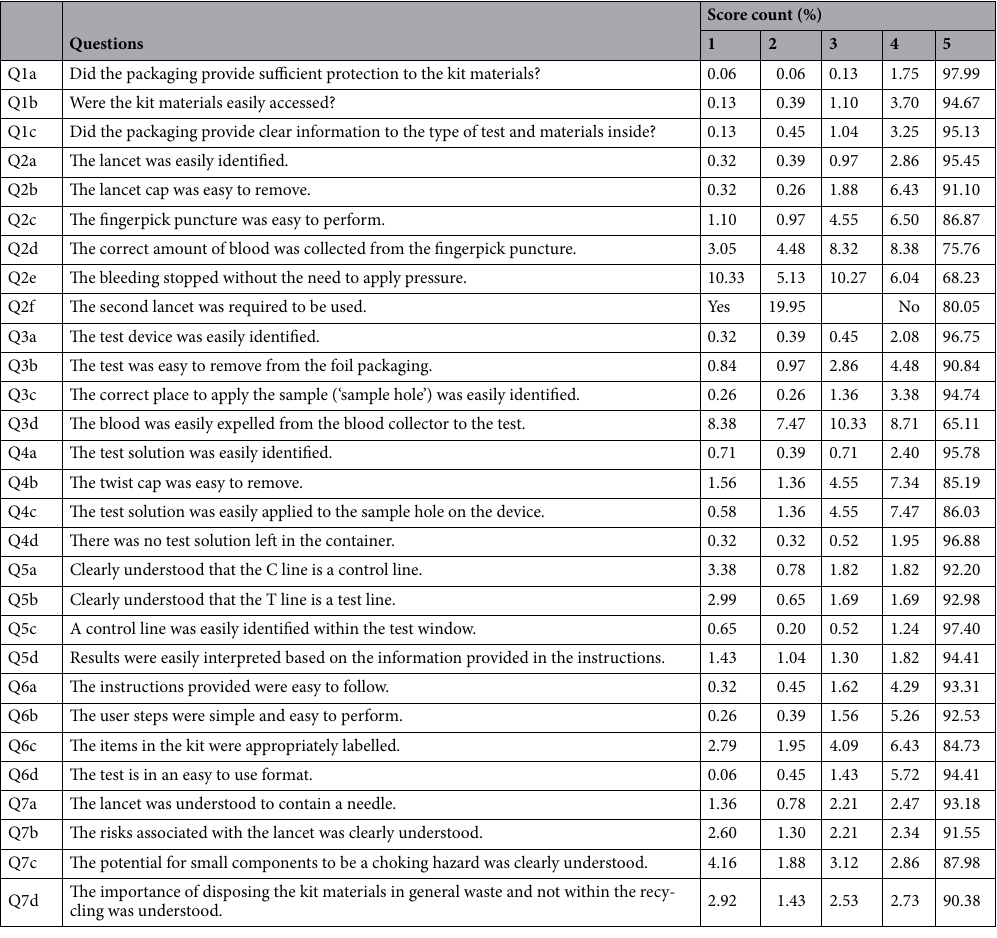
Table 2. The questions and participants’ score counts in %